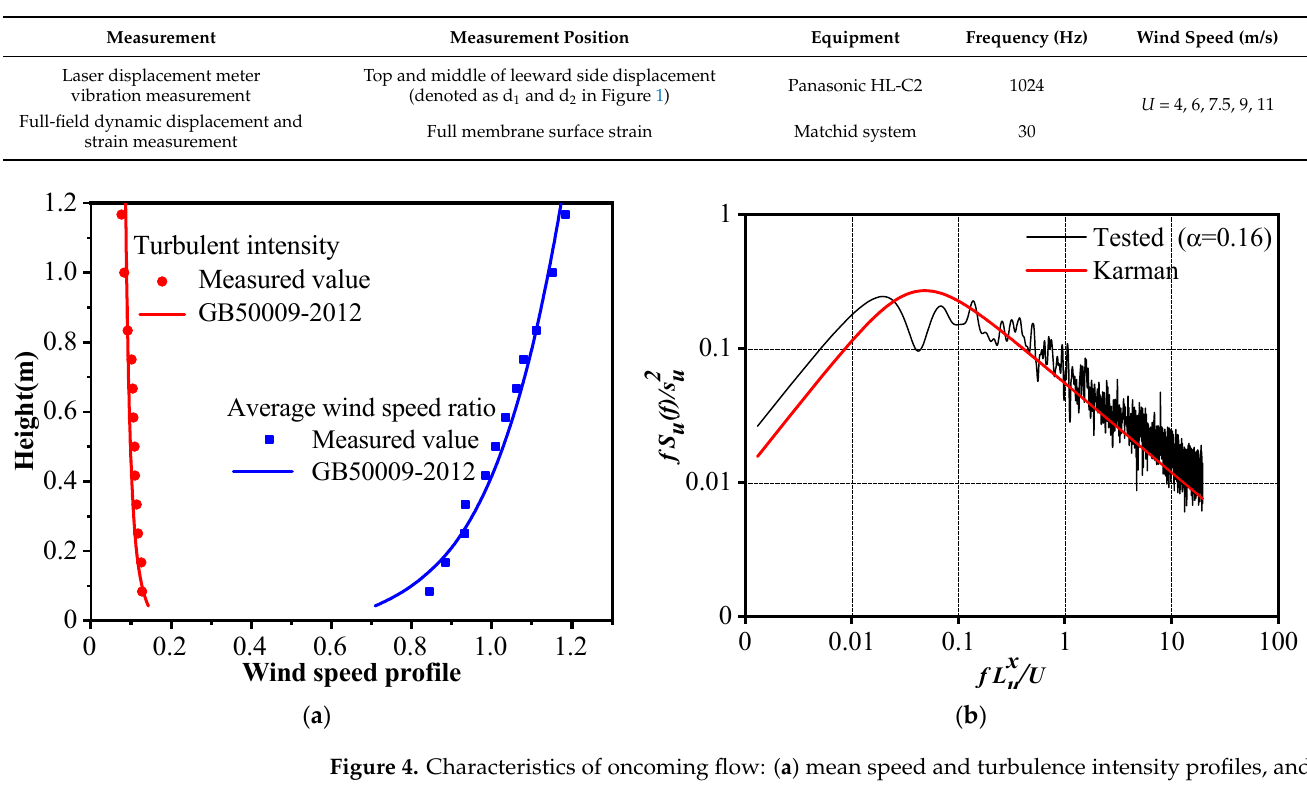
Table 2. Laser displacement and stereo cameras measurement cases.